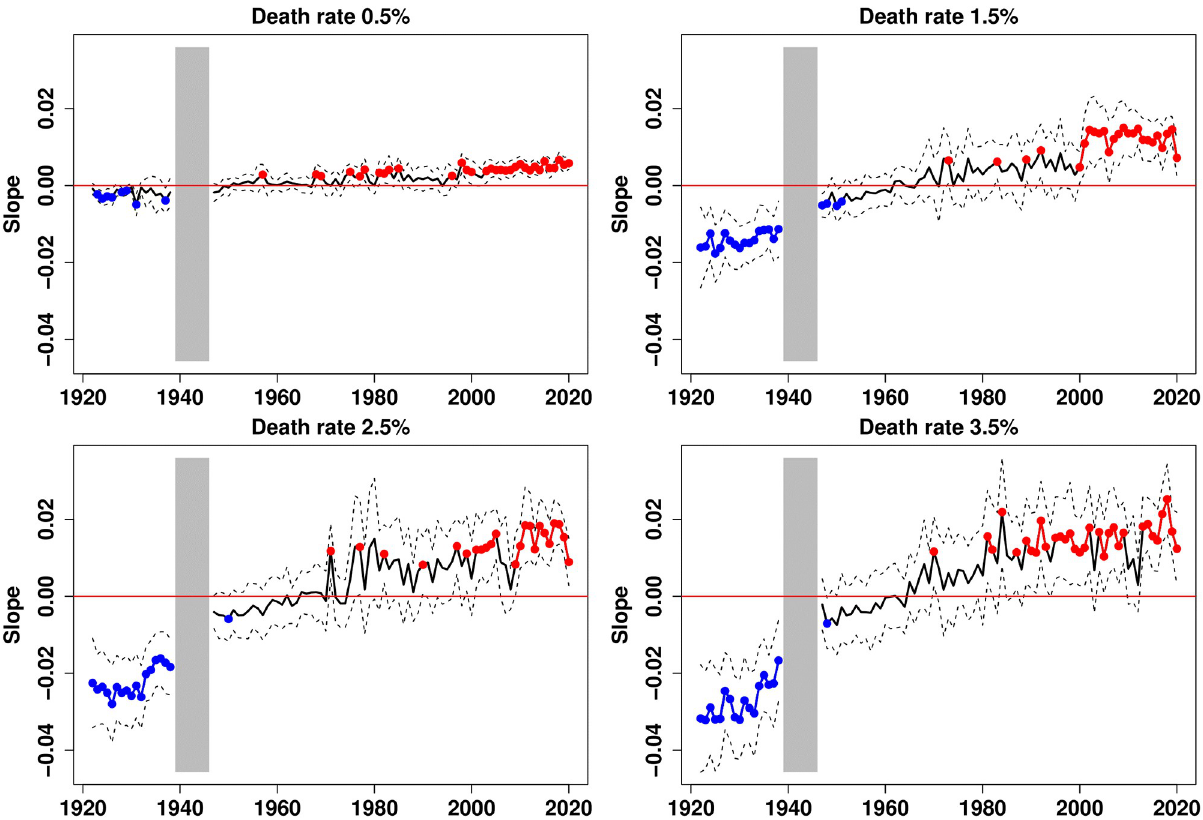
Fig 7. Income gradient in mortality for 4 mortality milestones, 1922–2020 (1922 classification). Plain curves plot the estimates of the linear trends across income groups; dotted lines are the 95% confidence intervals. Red dots indicate dates at which the slope is significantly positive, while blue dots indicate those with significantly negative slopes. Gradients are not represented for the period